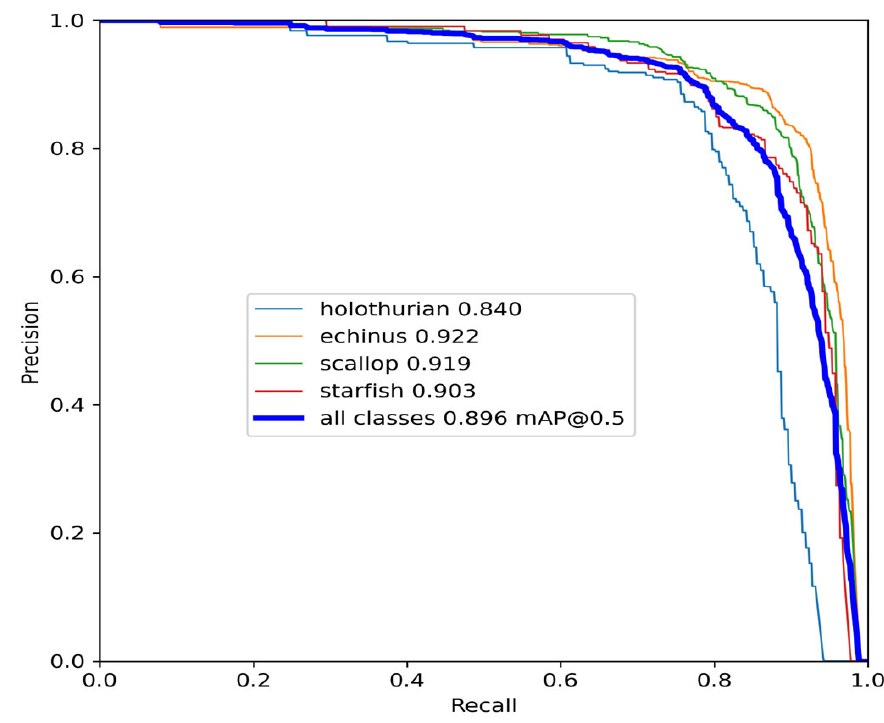
Figure 7. The precision-recall curve of the YOLOv7-AC model on the URPC dataset.